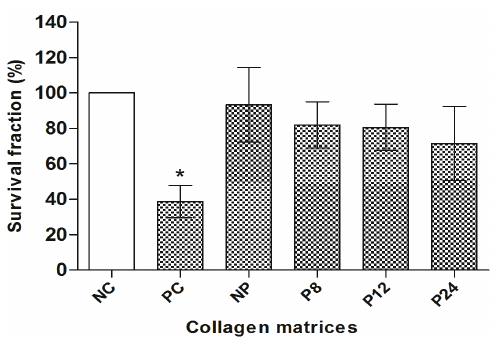
Figure 3. Clonogenic survival assay in CHO-K1. NC: negative control; PC: positive control. NC represents 100% survival fraction. Columns = mean of survival fraction (%); bars = standard error. * = p < 0.01 compared to NC, Dunnett’s test.